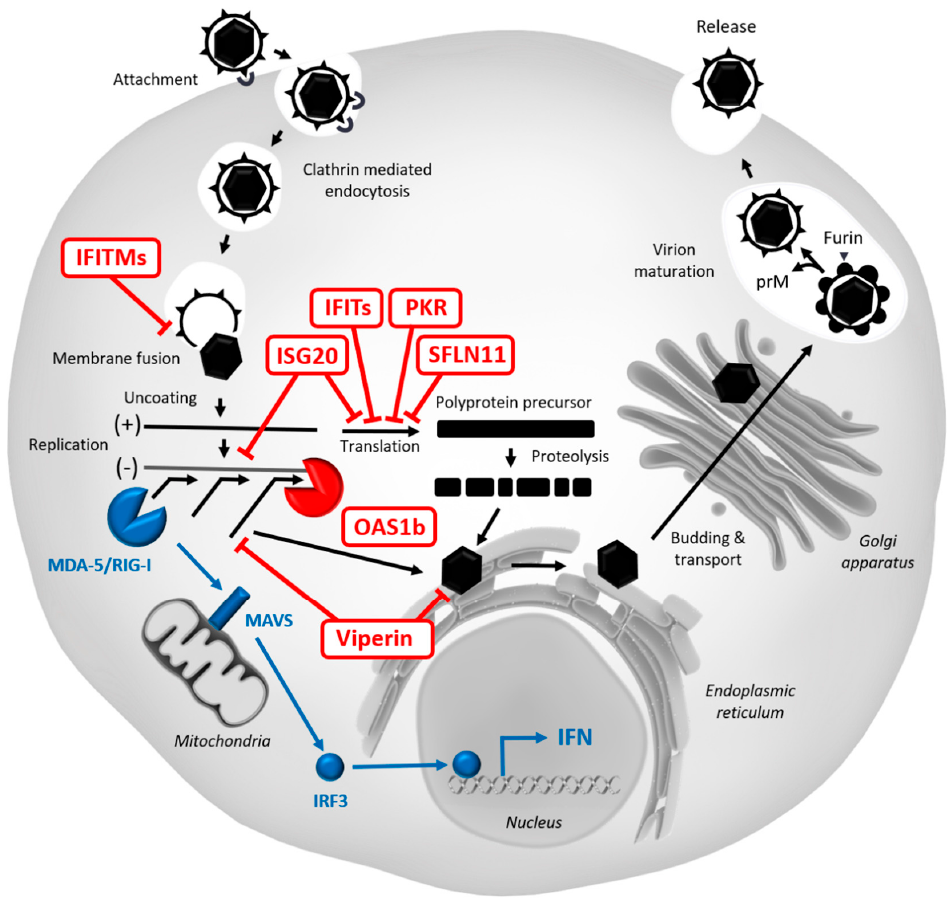
Figure 2. Restriction of WNV replication in human cells.